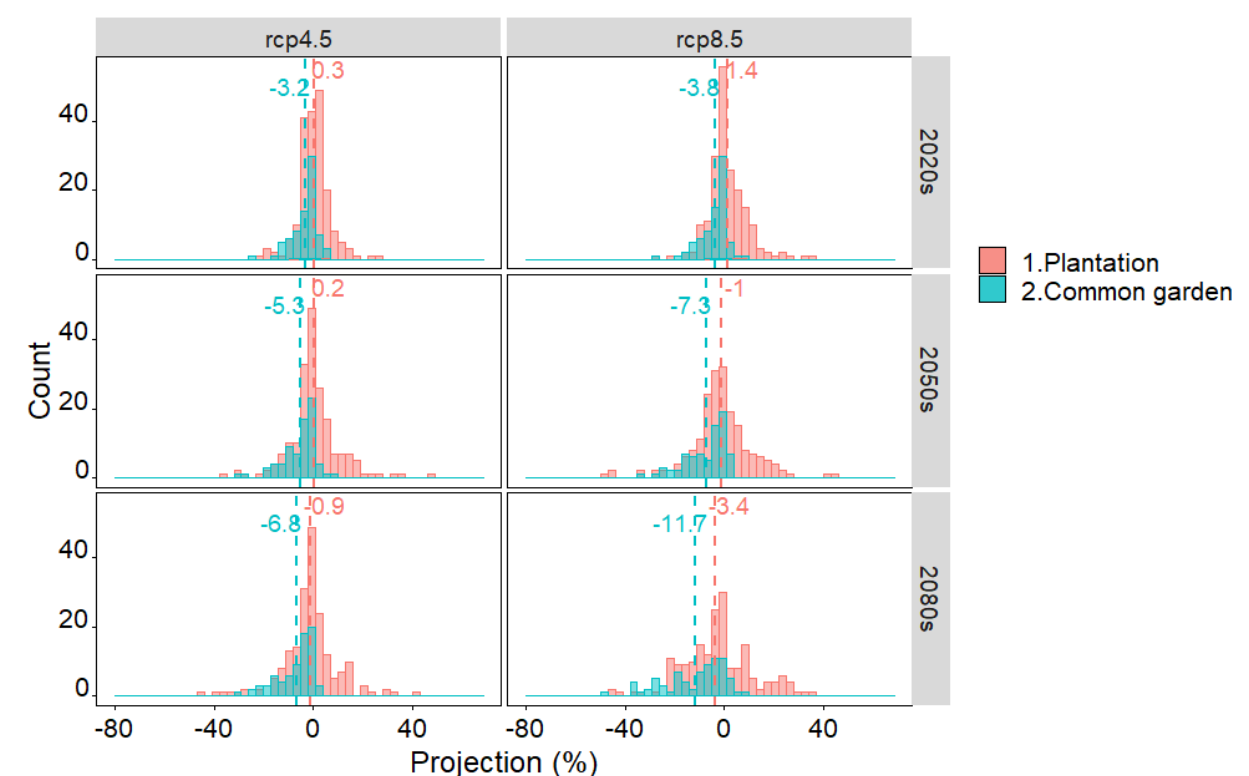
Figure 5. Histograms of predicted future growth of Norway spruce expressed as percentage of the growth for the reference period of 1991–2009. The variation in predicted growth is due to different climate response models between 13 different stands in west Denmark (dataset 1, plantation, red bars) and 5 field trials across Denmark (dataset 2, common garden, green bar), and among the 15 regional climate prediction models (based on either the RCP4.5 or the RCP8.5 scenarios). The periods 2011–2040 (2020s), 2041–2070 (2050s) and 2071–2100 (2080s) are shown. The projection of stand Ma and site 1013 were not included (see Section 2.5). The projected climate data were obtained from 15 Global Climate Models (AOGCMs) of the CMIP5 multi-model considering the emission scenario RCP4.5 and RCP8.5, as available at http://tinyurl.com/ClimateEU. For further information about the calculation of the projections, please see supplementary Table S1 and Table 5 in Huang et al. [9].